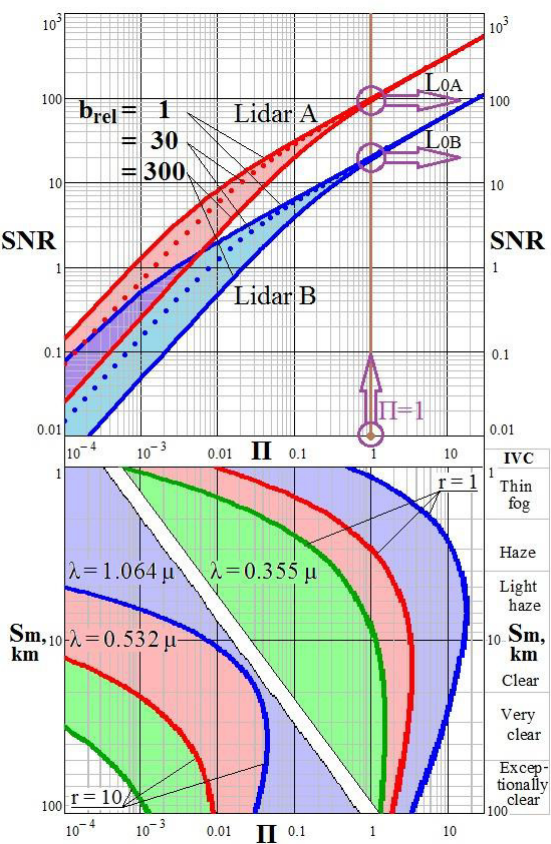
Fig. 3. Comparison of A and B lidars potentiali- ties on the “map” SNR = f(Π ). Lidars are consid- ered sounding the same atmosphere for different values of the background noise